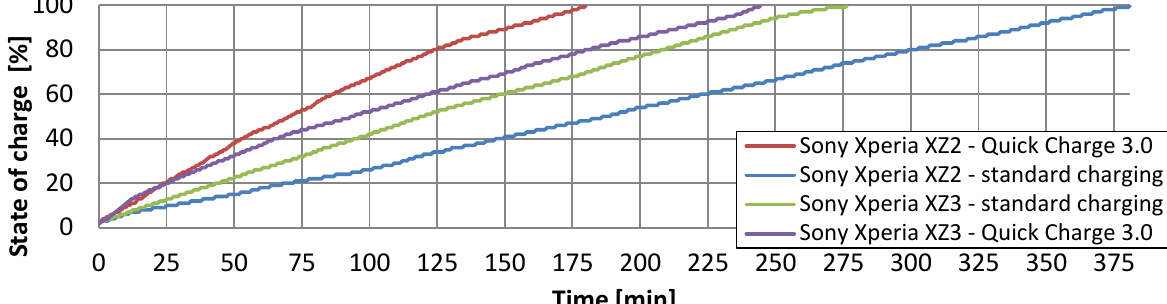
Fig. 1. State of charge characteristics as a function of time for Quick Charge and standard charging for selected smartphone models.